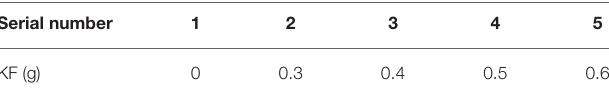
TABLE 1 | Formulation for KF@VIM/EGDMA dispersion. Serial